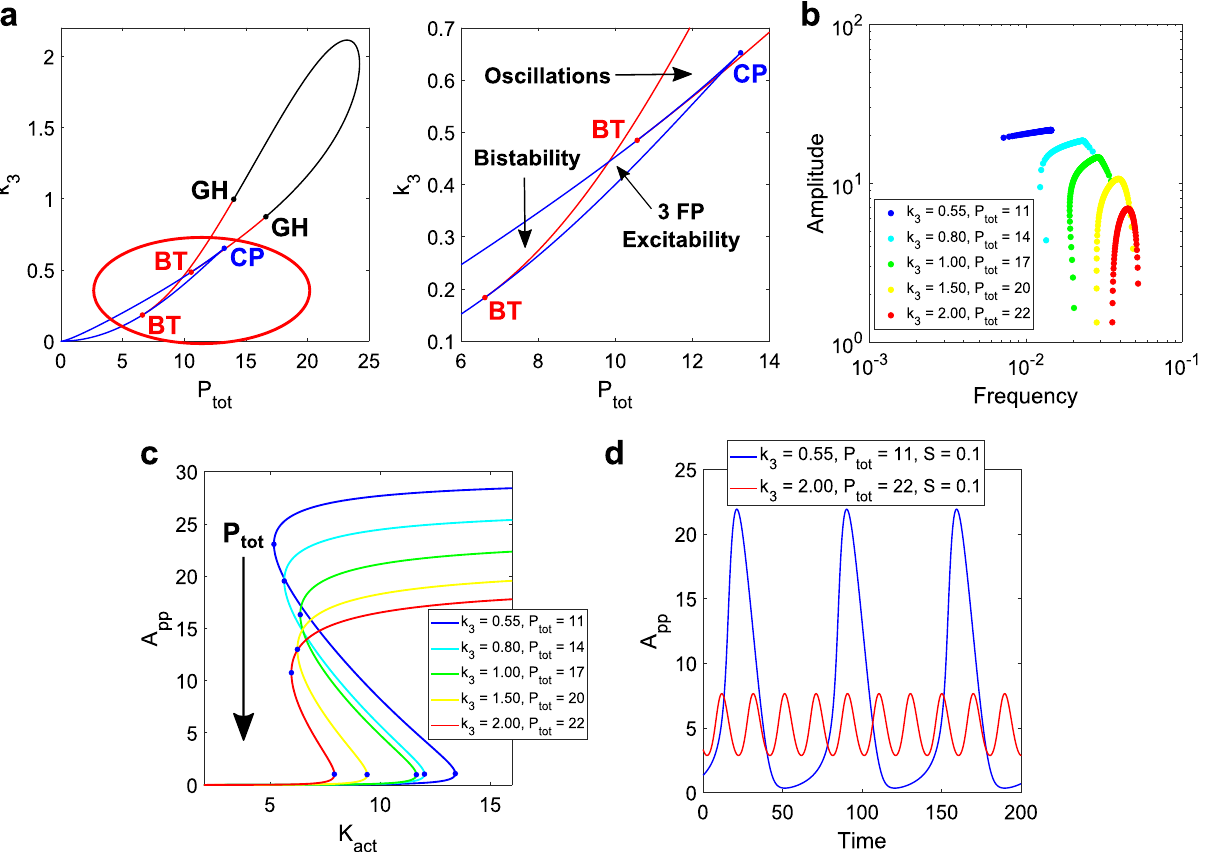
Figure 4. Results for the k 3 vs P tot analysis in the SK model. ( a ) 2D bifurcation diagram for the two parameters. In black, the supercritical Hopf curve. In red, the subcritical one. In blue, the SN curves with the CP at the joint. GH bifurcations in black. BT bifurcations in red. A bistable region develops for low values of k 3 and low values of P tot . ( b ) Amplitude vs. frequency curves for different pairs of k 3 and P tot , scanning the parameter S. A transition in the shape of these curves is observed like in the previous analysis, the amplitude now reaching higher values than when only modifying k 3 . ( c ) DP bistable curves while scanning K act for each pair selected, showing the clear increase in amplitude as P tot is lowered. ( d ) Time series for two extreme cases, showing the contrast in shapes within the oscillatory